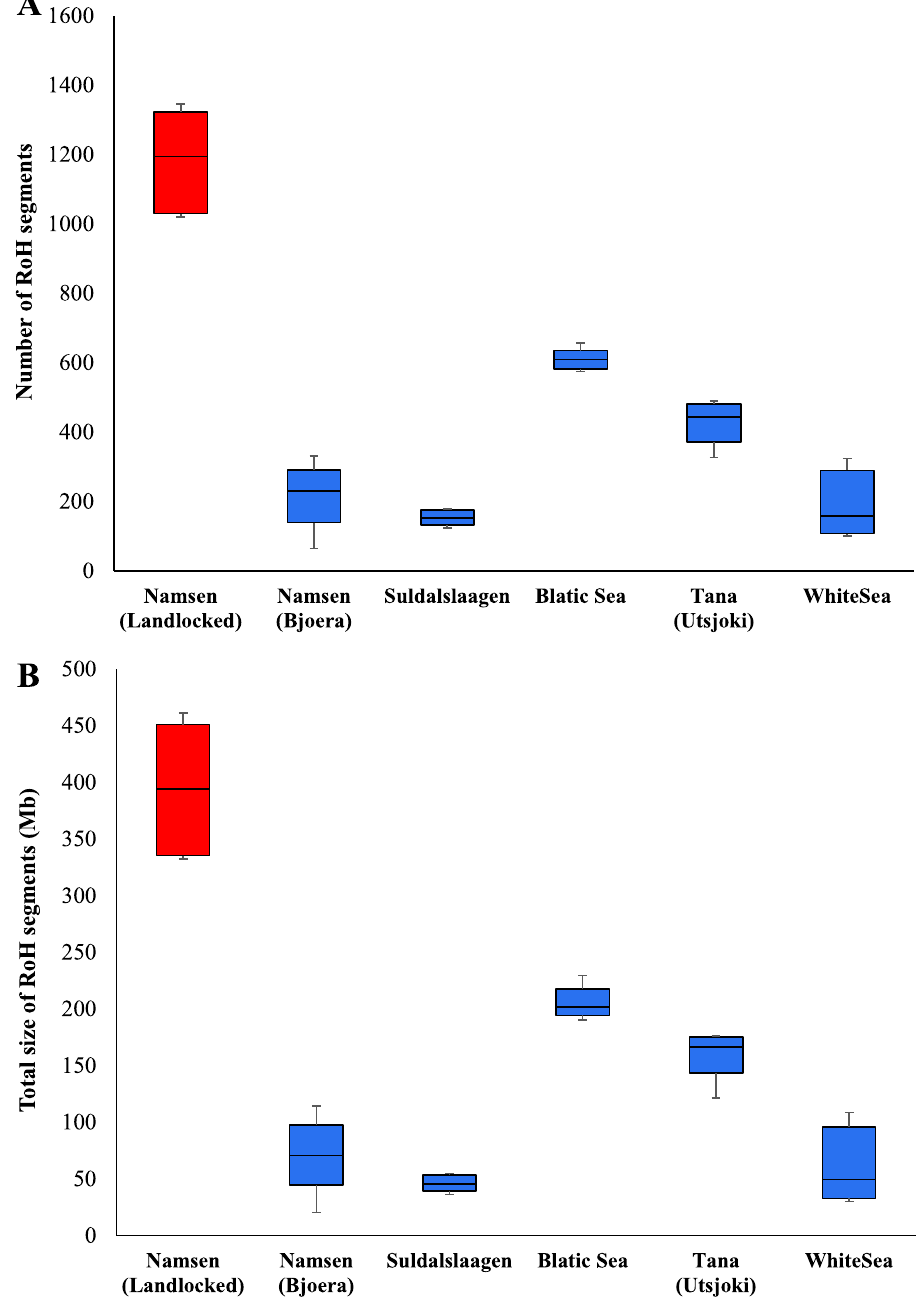
Figure 3. Box plot showing ( A ) the number and ( B ) the total size of runs of homozygous (RoH) segments in landlocked and anadromous salmon populations. The centre line denotes the median, the boundaries of the box represent the first and third quartiles, and the whiskers show the maximum and minimum values. The mean number of RoH of the landlocked salmon population was significantly higher than those of anadromous populations (at least, P = 0.0003). Similarly, the average size of RoH of the landlocked salmon population was significantly higher than those of anadromous populations (at least, P =